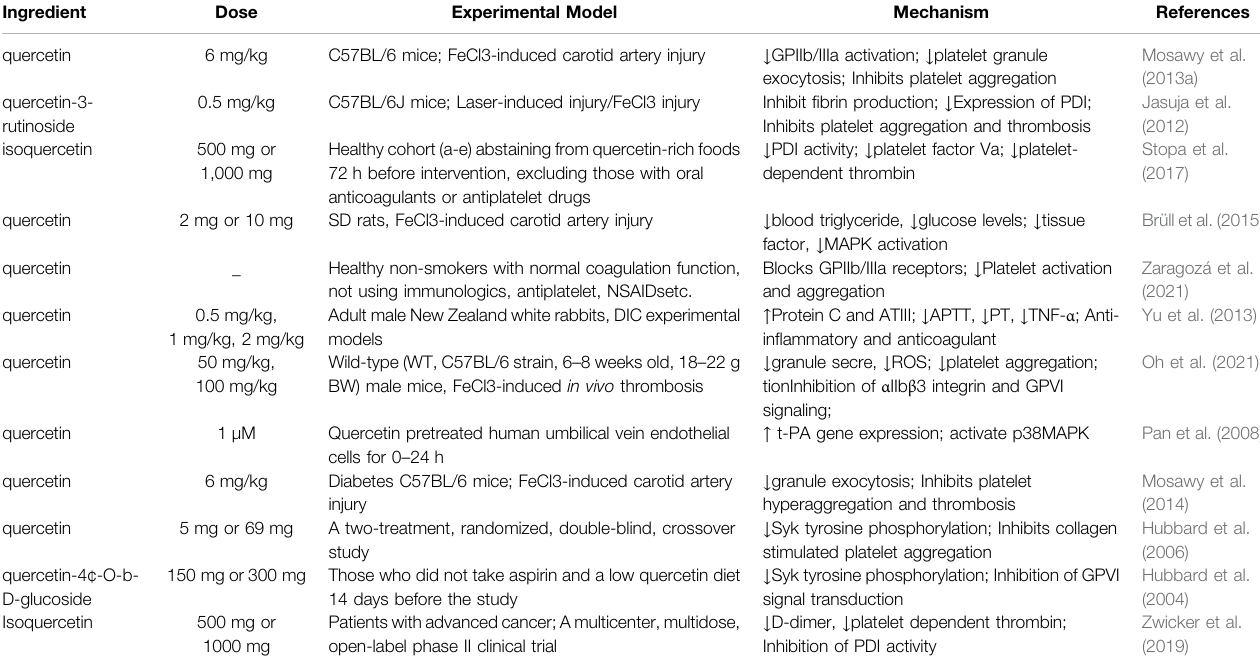
TABLE 2 | Anti-platelet aggregation effect of quercetin.